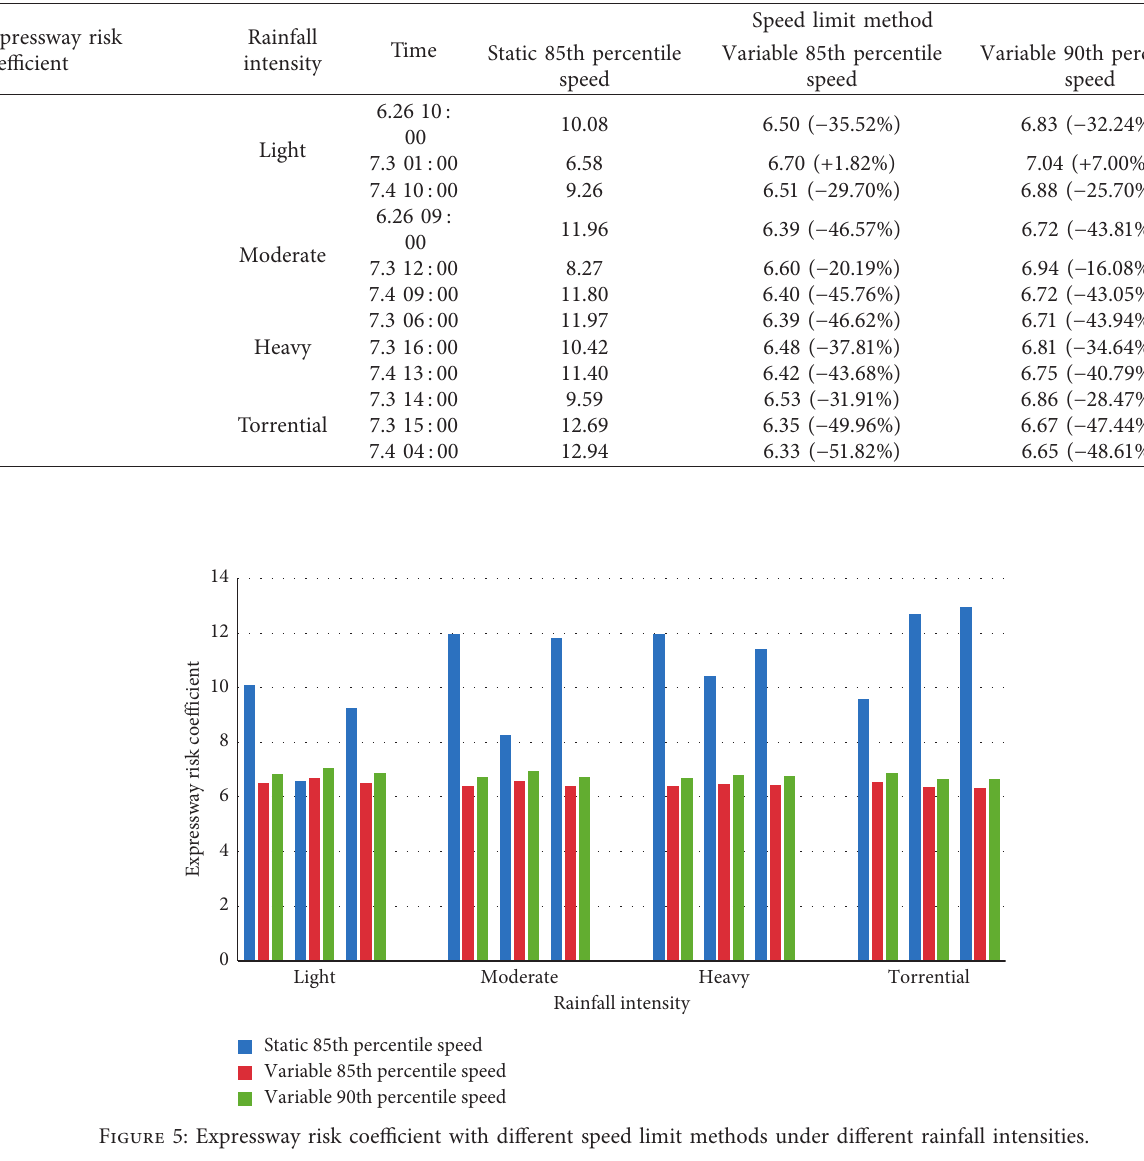
Table 4: Expressway risk coefficient with different speed limit methods under different rainfall intensities.